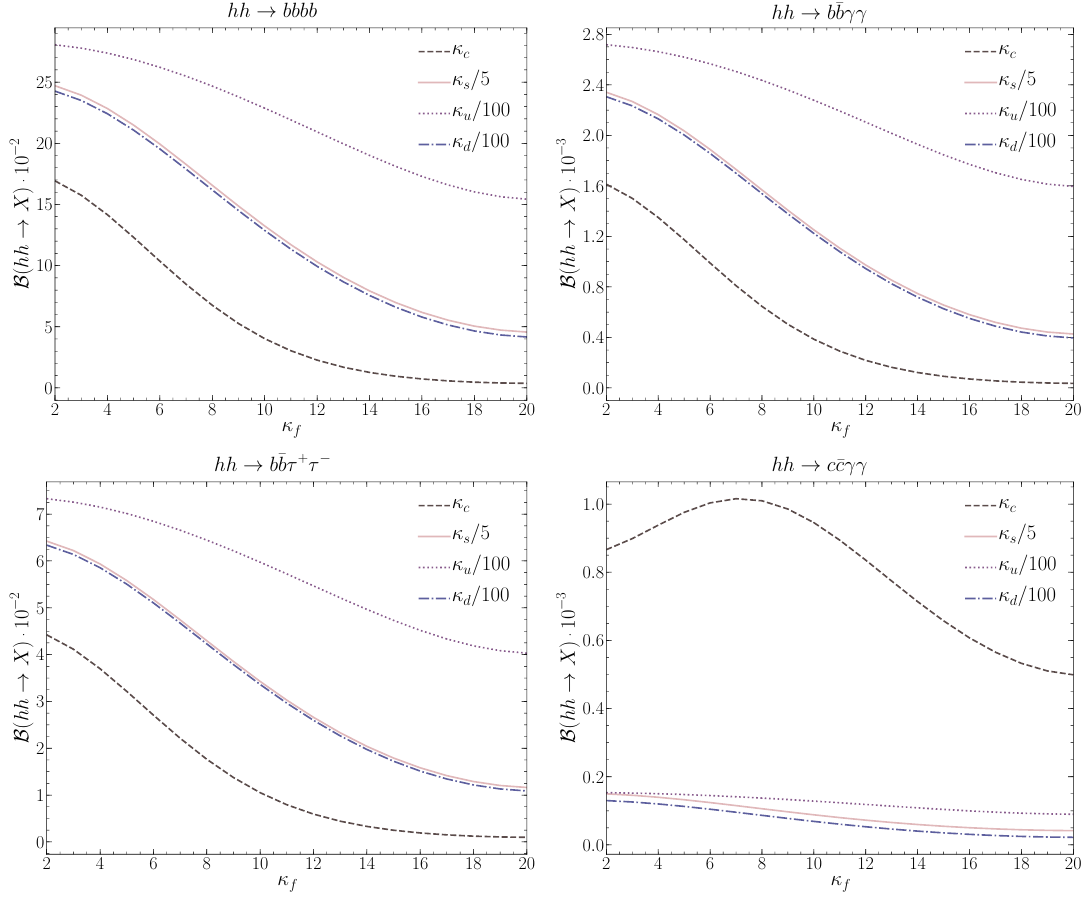
Figure 9 . Di(cid:11)erent Higgs pair (cid:12)nal states BRs including state-of-the-art QCD corrections as functions of the coupling modi(cid:12)cation factors (cid:20) f . Top left : hh ! bbbb . Top right : hh ! bb(cid:13)(cid:13) . Bottom left : hh ! bb(cid:28) + (cid:28) (cid:0) . Bottom right : hh ! cc(cid:13)(cid:13)